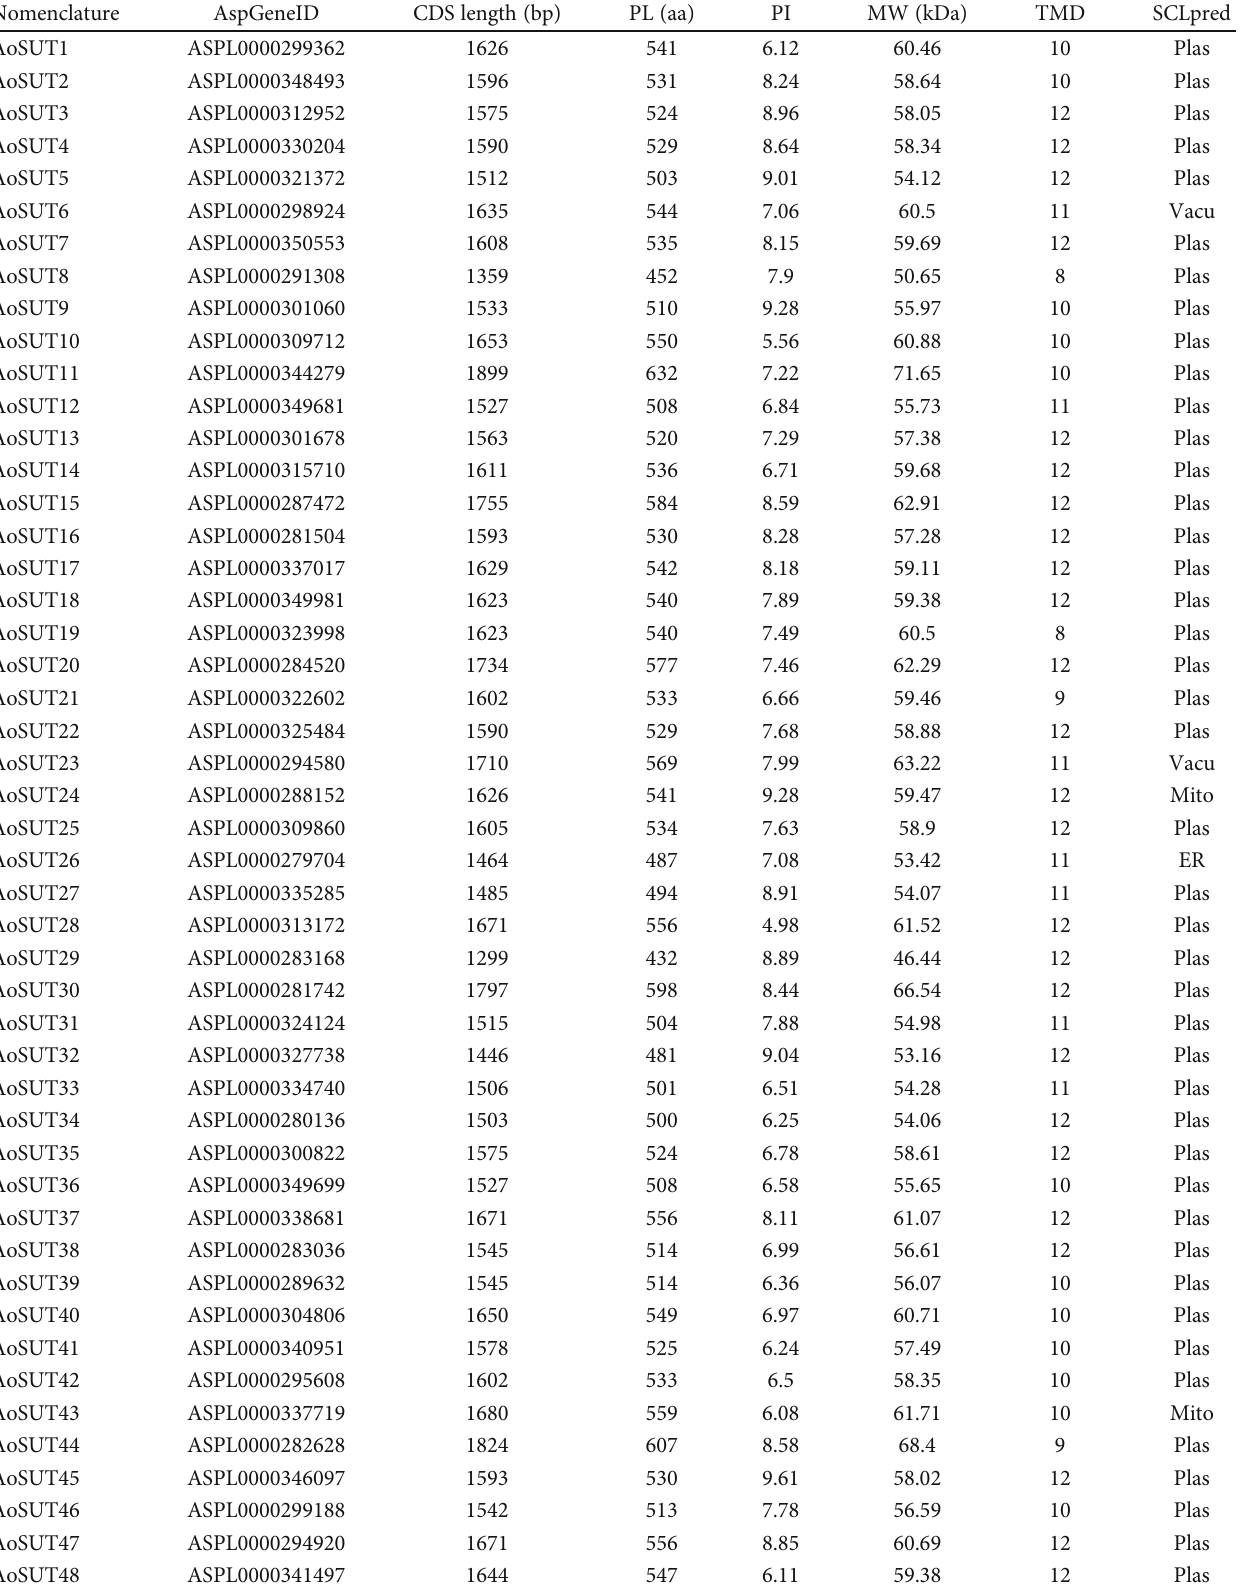
Table 1: The member of SUT gene family in A. oryzae